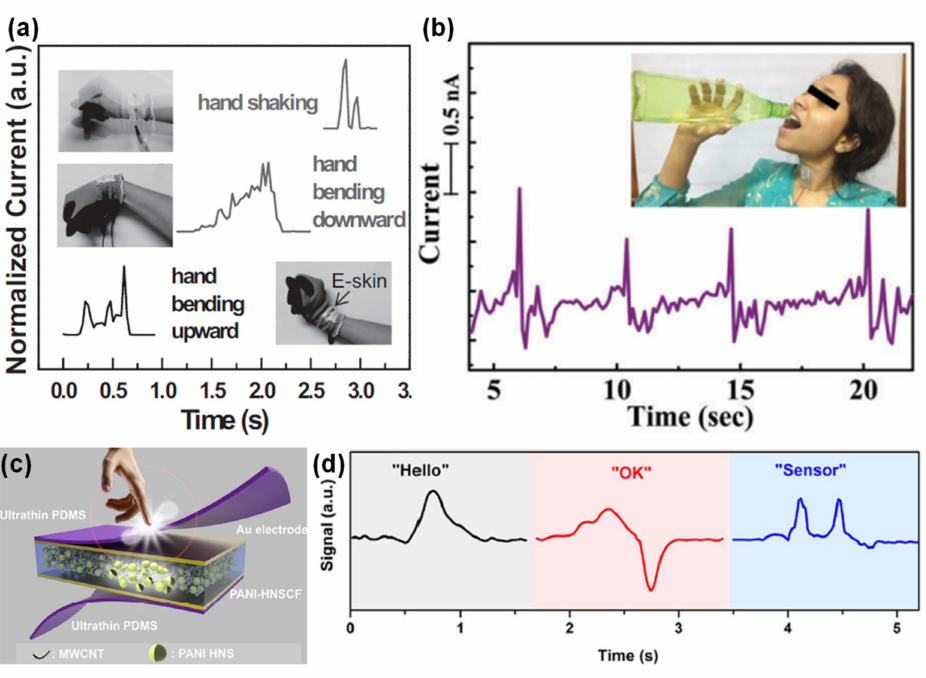
Figure 14. E-skins applied to muscles movements detection. ( a ) E-skin developed by Yang-Fang Chen and co-workers in 2016 for the detection of hand shaking and wrist movement [271] (Copyright © 2020 WILEY-VCH Verlag GmbH & Co. KGaA, Weinheim, Germany). ( b ) Output of the e-skin developed by Dipankar Mandal and co-workers in 2017 when drinking (used with permission of Royal Society of Chemistry, from [272]; permission conveyed through Copyright Clearance Center, Inc.). ( c ) E-skin developed by Guozhen Shen and co-workers in 2017 [239] ( © 2020 Elsevier Ltd. All rights reserved.). ( d ) Output of the e-skin in (c) when speaking di ff erent words [239] ( © 2020 Elsevier Ltd. All rights